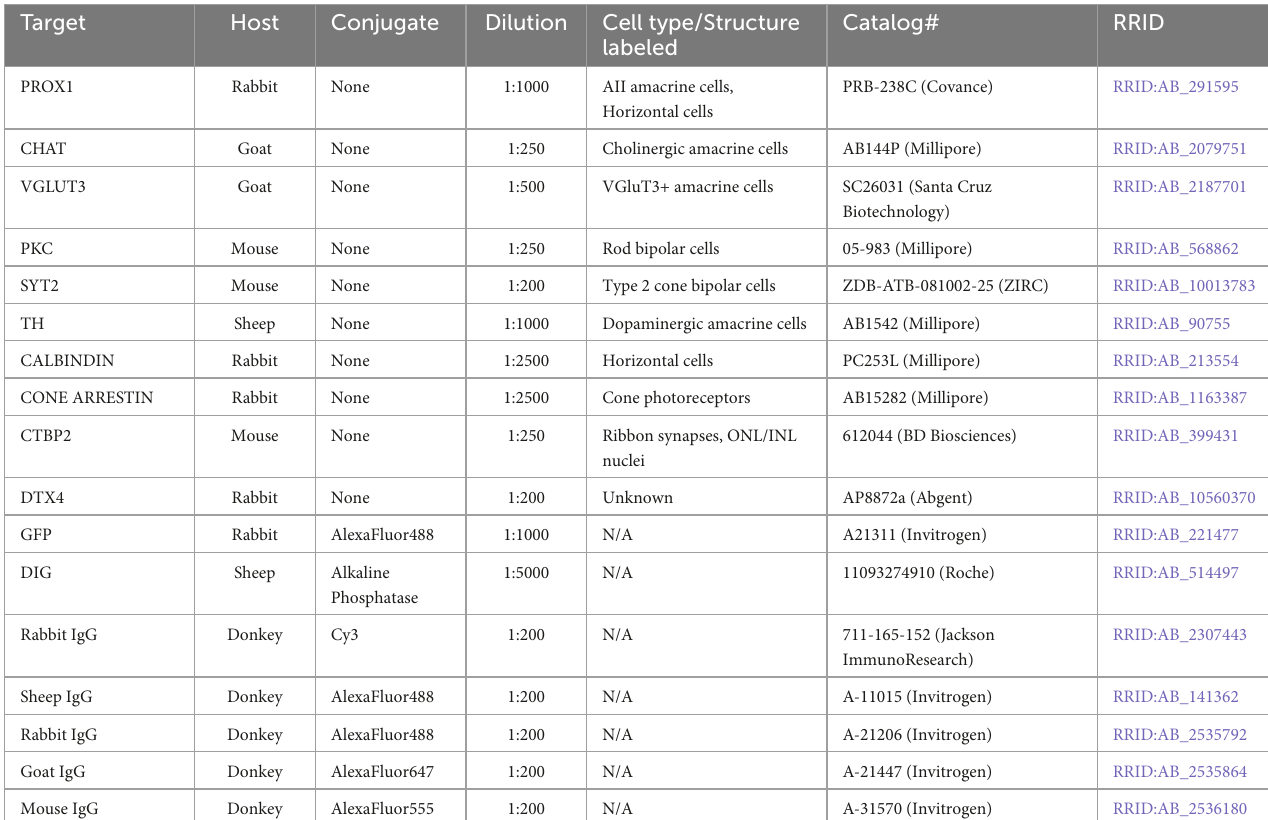
TABLE 1 Antibodies used in this